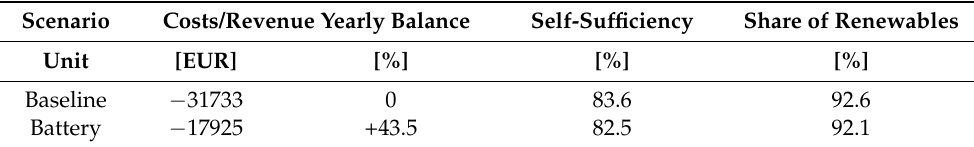
Figure 4. Battery scenario: Monthly revenue/cost results. Table 3. Yearly profitability, self-sufficiency, and share of renewables for the baseline vs battery scenarios. Scenario